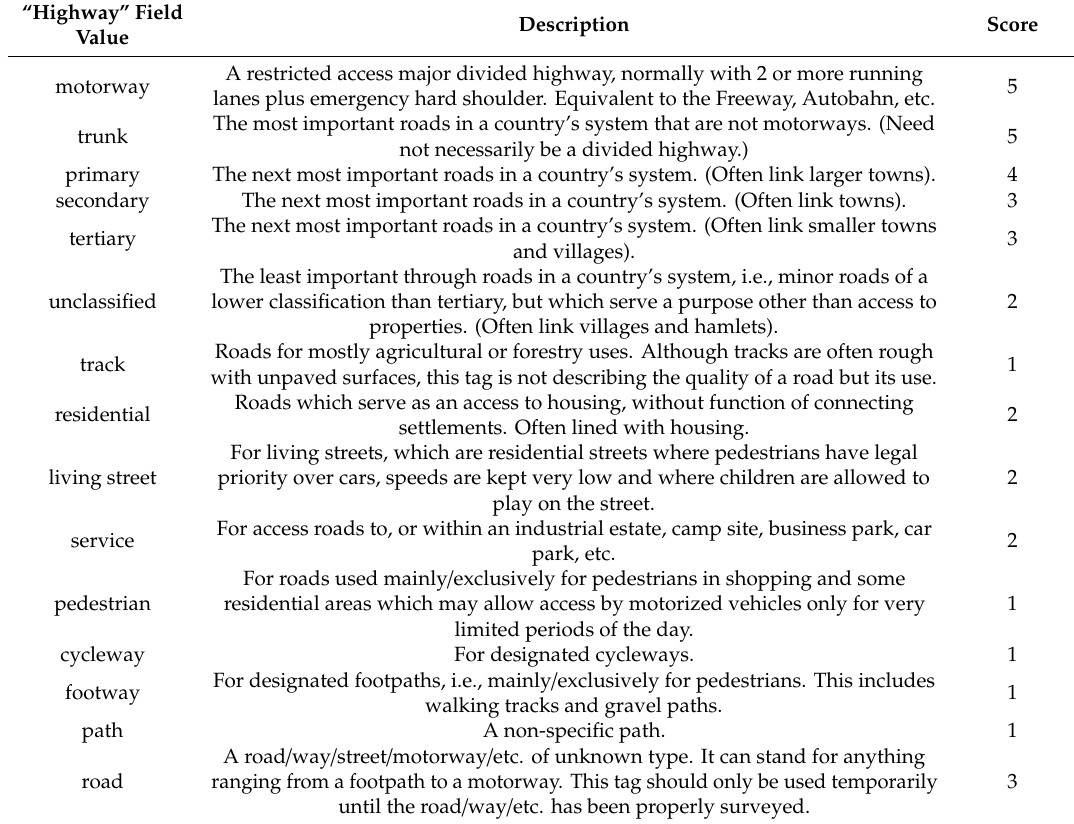
Table 4. Pressure scores assigned to di ff erent types of roads from the OSM layer.